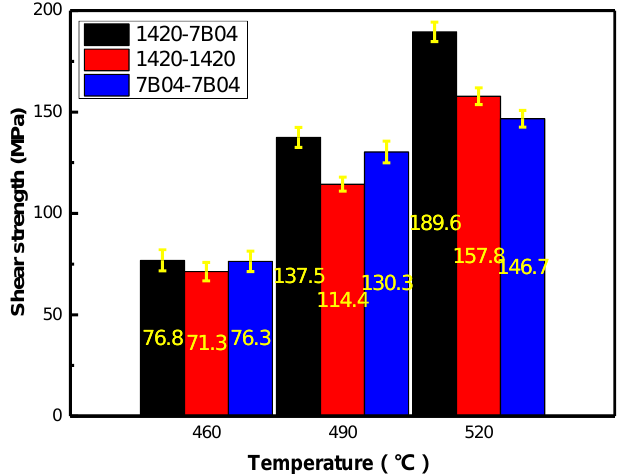
Figure 4. Shear strength of different bonded joints under different bonding parameters.